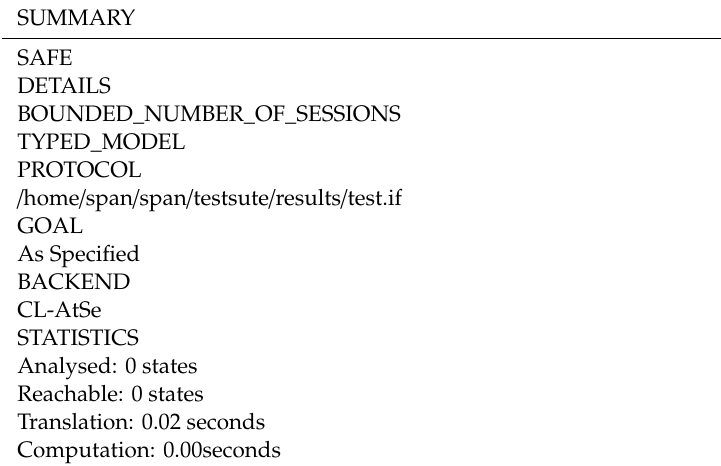
Table 3. The result of simulation CL-AtSe